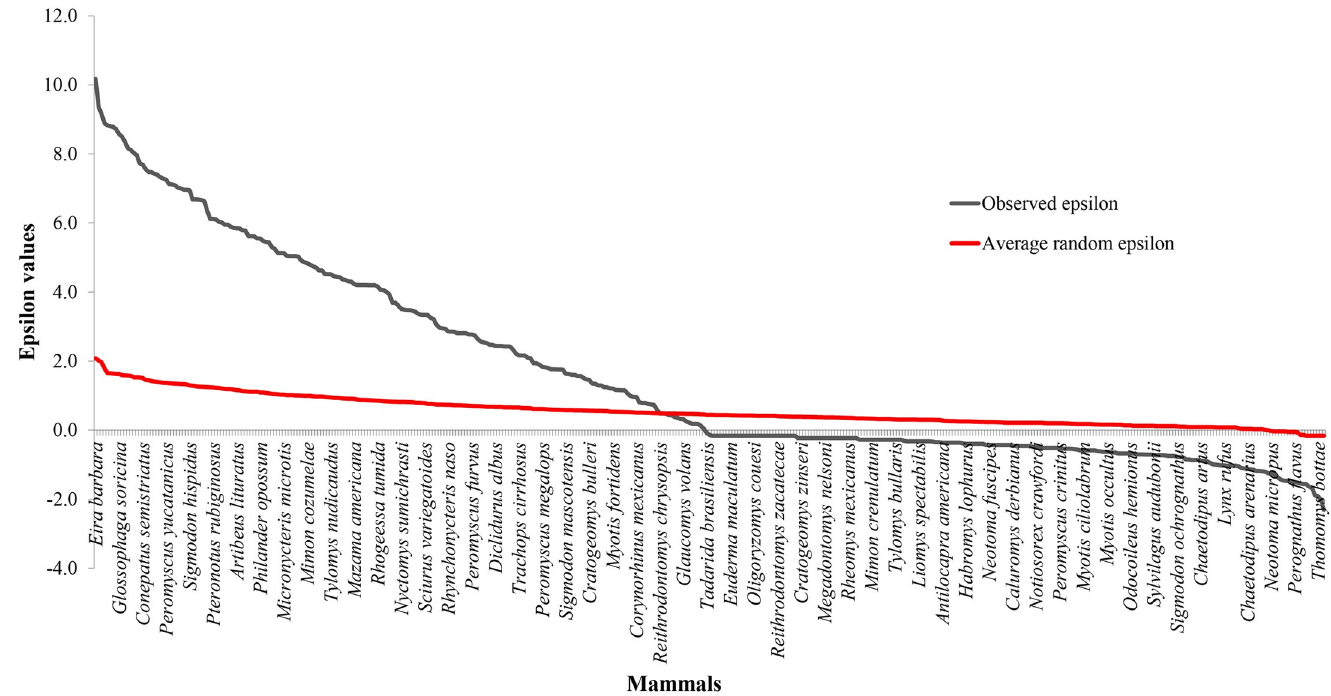
Fig 1. Graph of ranked epsilon values for all mammal species compared to that of a random distribution. The Average random epsilon line represents the distribution of overlaps found by randomly redistributing all collections over those spatial cells that had at least one collection.